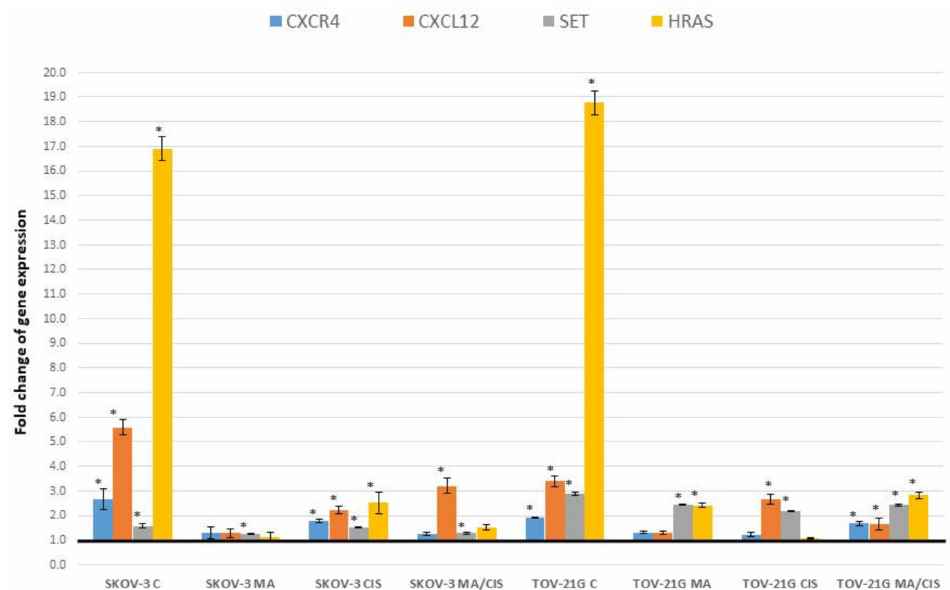
Figure 5. Effect of exosomes derived from SKOV-3 and TOV-21G cells (untreated with drugs, α - mangostin and/or cisplatin-treated) on the expression of receptors CXCR4 and their ligand CXCXL12 and SET and HRAS gene in fibroblasts. The data are shown as mean ± SD of triplicate experiments, statistically significant results * ( p <